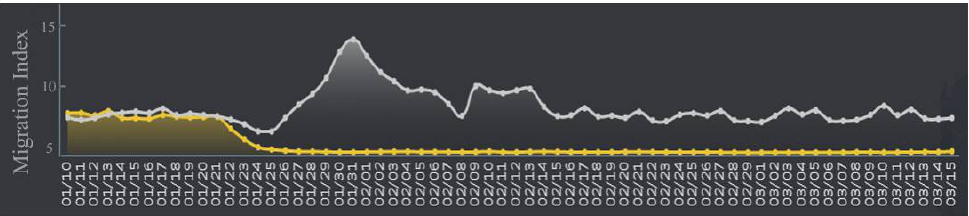
Figure 10. The comparison of the migration populations during the Spring Festival in 2019 and 2020 (the data is provided by the Baidu migration platform [34]).